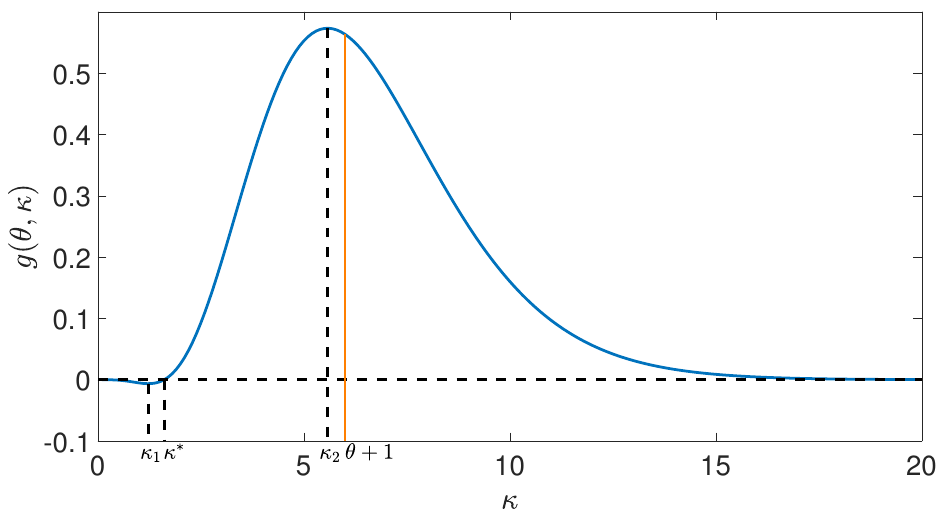
Figure 4. g ( θ , κ ) as a function of κ for θ = 5 and m / n = 4. κ 1 ≈ 1.2262, κ 2 ≈ 5.5756 < 6, and κ ∗ ≈